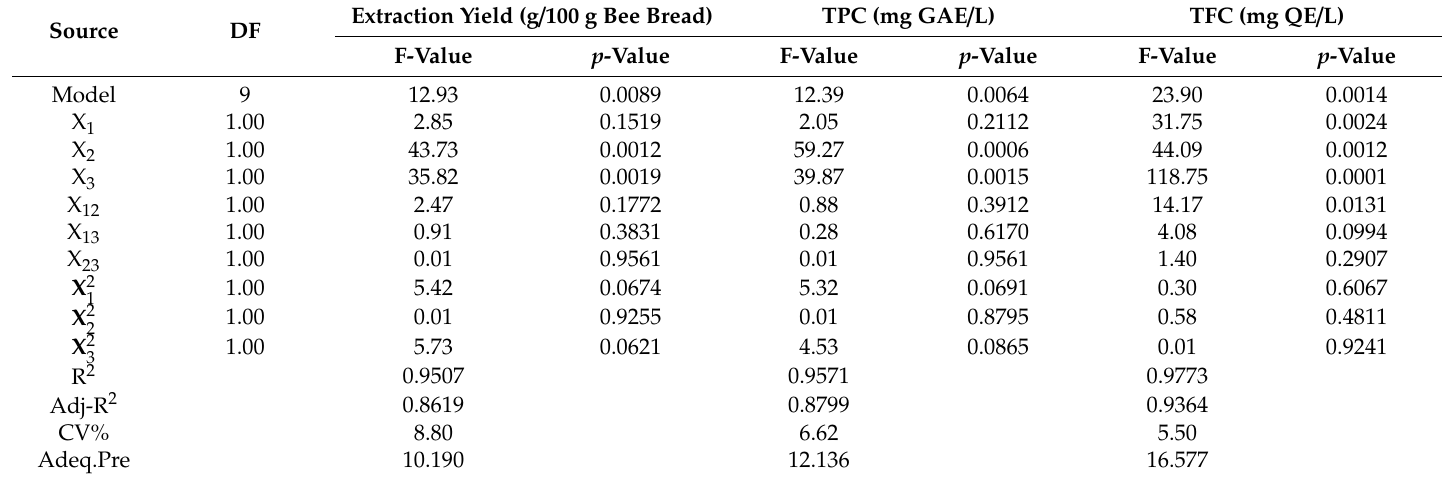
Table 4. ANOVA analysis of response surface method (RSM) model response for extraction yield, TPC and TFC from bee bread.